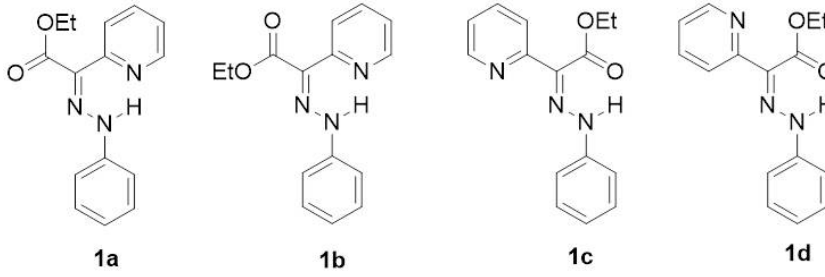
Figure 3. Selected E -isomers ( 1a and 1b ) and Z -isomers ( 1c and 1d ) of compound 1 . The theoretical calculations imply that E -configurations are energetically preferred in acetonitrile over the Z -configurations at both M062X/cc-pVTZ and M062X/6-31+G(d,p) levels of theory. Here, the M062X/6-31+G(d,p) results are compared with the MN12-SX /6-31+G(d,p) ones (Table 1). Table 1. Gibbs energy differences in the gas phase ( ∆ G 1 /dielectric constant ε = 1) and in